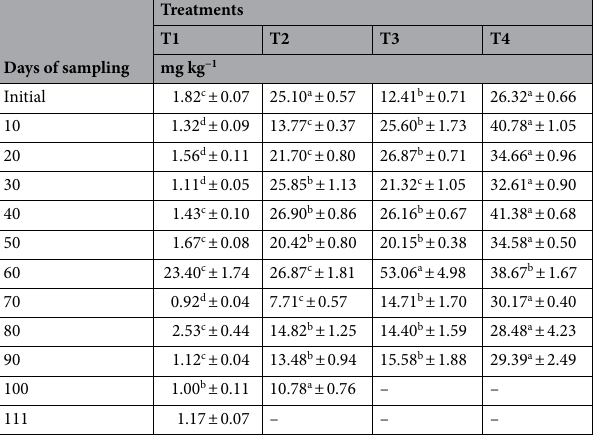
Table 12. Chicken litter biochar on available phosphorus at one hundred and eleven days after transplanting MR219. Different letters within a row indicates significant difference between means of four replicates ± standard error using Tukey’s test at p ≤